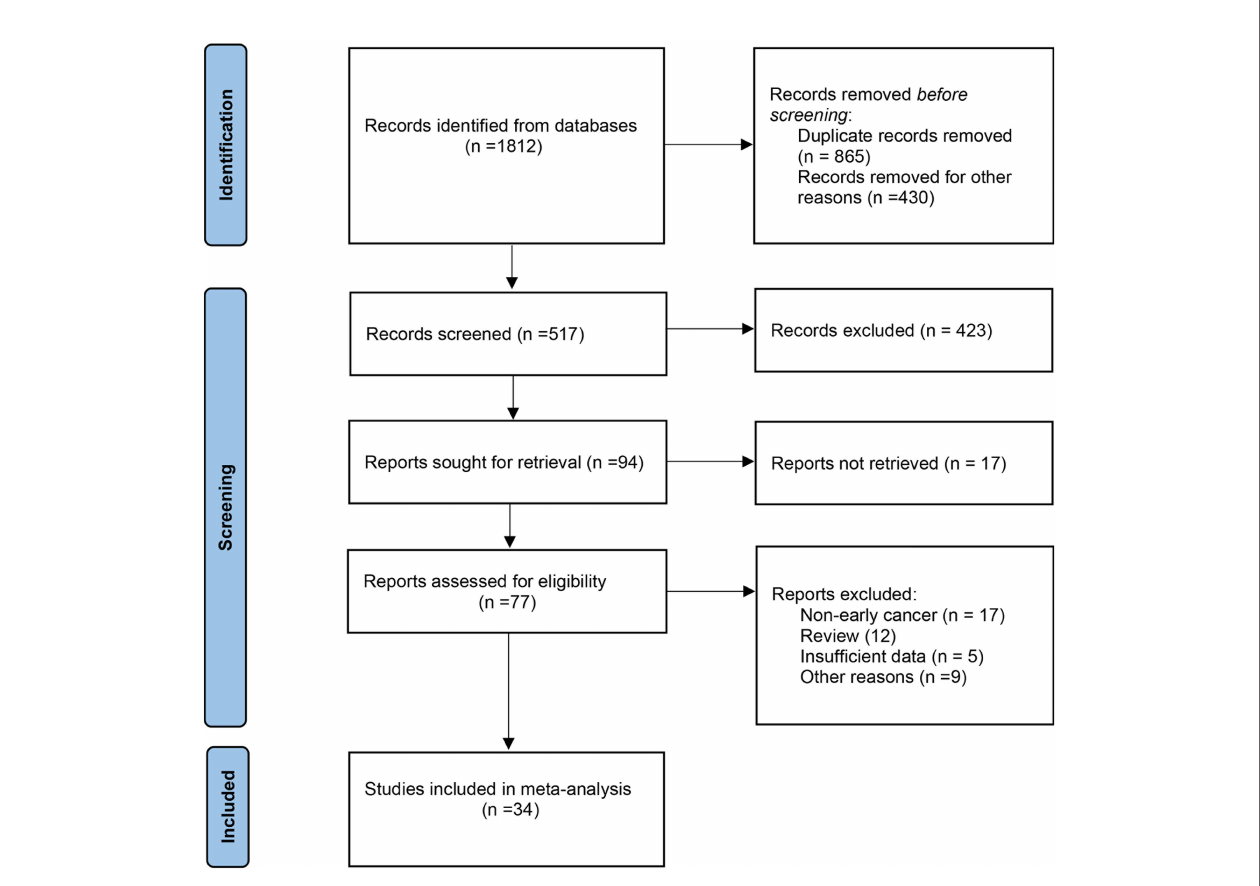
FIGURE 1 | An overview of the study screening